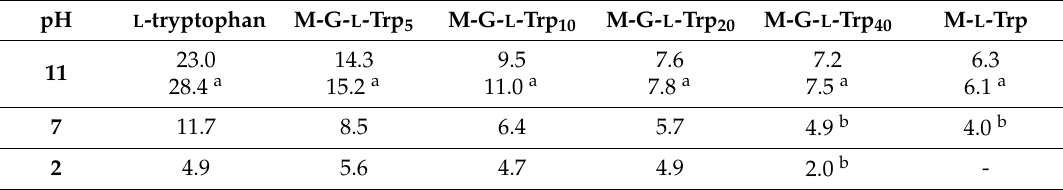
Table 4. Quantum yields of L -tryptophan, M-G- L -Trp and M- L -Trp copolymers at different pH’s. All values should be considered with a ± 5%